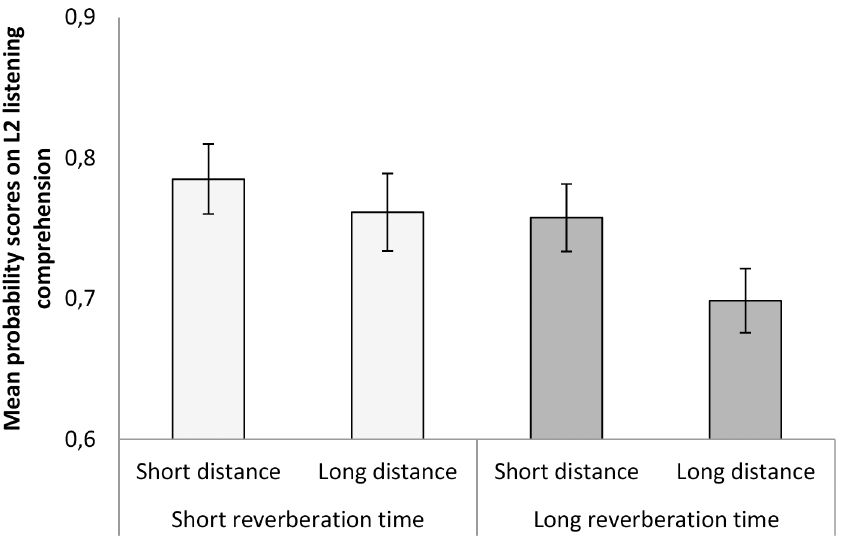
Fig 1. Mean probability scores on L2 listening comprehension. Swedish speaking participants ’ scores on a second-language (English) listening comprehension test (as part of the National Tests of English in the Swedish School System) in a classroom with a short reverberation time (0.33 sec) and a classroom with long reverberation time (1.07 sec) at two different distances from the sound source (1.05 m versus 6.13 m away from the sound source). Error bars represent standard error of